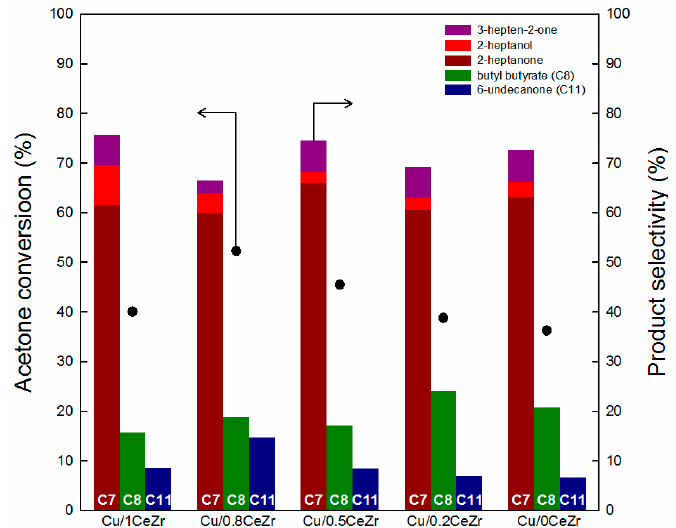
Figure 4. Acetone conversion and product selectivities of Cu/ x CeZr catalysts. C7 includes 3-hepten-2-one, 2-heptanone, and 2-heptanol.